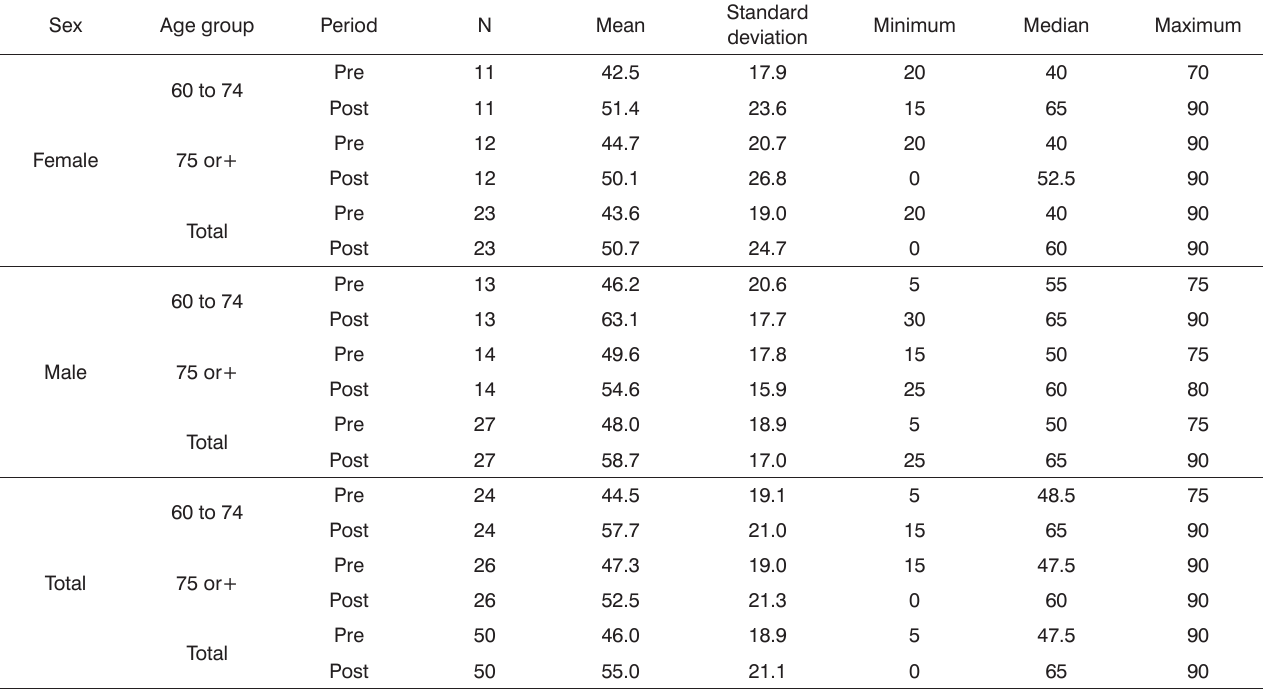
Table 7. Analysis of variance and descriptive statistics for the vitality aspect according to sex and age group. Sex